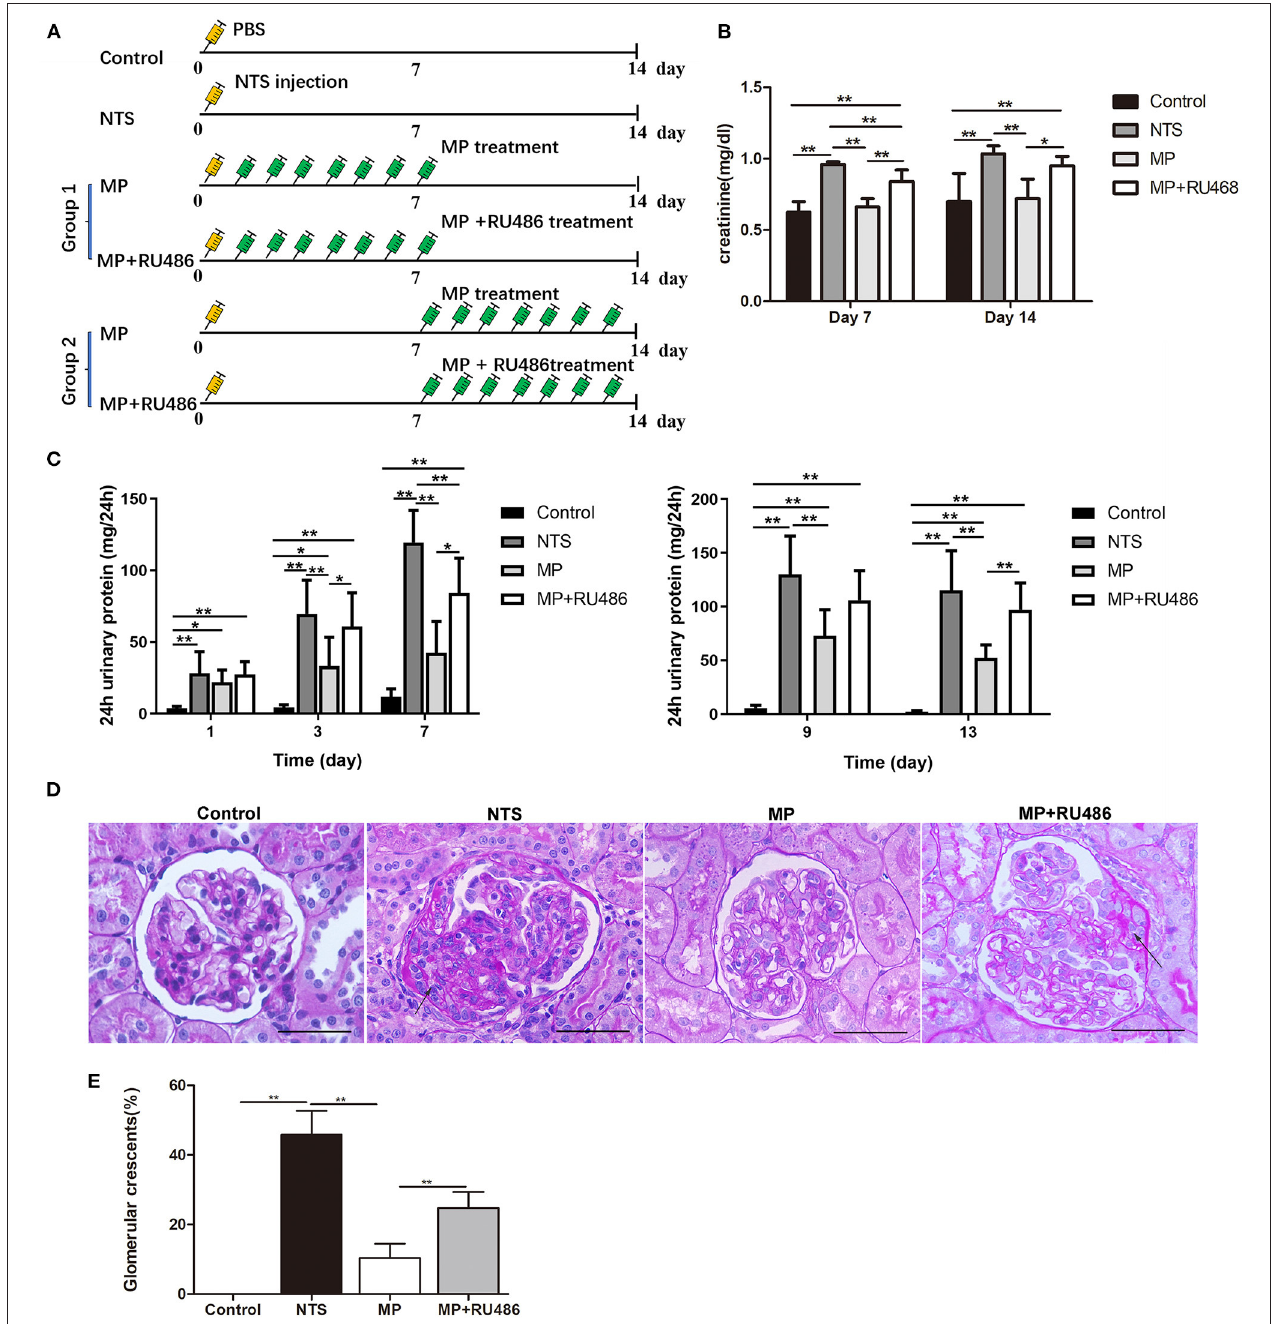
FIGURE 3 | Glucocorticoid treatment attenuated the progression of rat anti-GBM glomerulonephritis. (A) Schematic of experimental design. (B) serum creatinine concentration of rats on day 7 and 14 after NTS injection ( n = 5 per group). (C) 24-h urinary protein levels of rats on day 1, 3, 7, 9, and 13 after NTS injection ( n = 5 per group). (D) Periodic acid–Schiff staining of kidney from rats 14 days after NTS injection showing crescent formation (arrows) in glomeruli. (E) The percentage of cellular crescents in rats.** P < 0.01, * P < 0.05 vs. controls. Scale bars, 50 µ m. relative mRNA expression of HB-EGF and EGF were both EGF, was markedly upregulated in glomeruli after induction significantly downregulated in cultured podocytes treated with of NTS nephritis ( Figure 8A ), which was in parallel with Dex. These observations demonstrated that glucocorticoids activation of EGFR/STAT3 signaling ( Figure 4 ). MP treatment exert its effect through inhibition of EGF ligand expression significantly inhibited the upregulation of mRNA of HB- ( Figure 8B EGF and EGF ( Figure 8A ). In vitro , we found that the